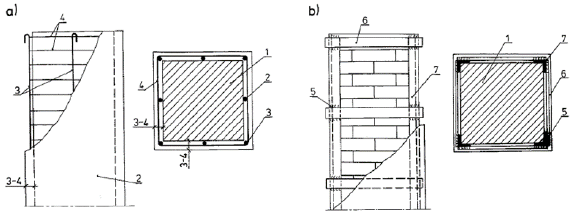
Figure 1: Clamps used in brick column reinforcement: a) reinforced mortar clamp; b) steel clamp [15] where: 1 – reinforced column; 2– cement mortar; 3– reinforcement; 4– reinforcement; 5- grout;